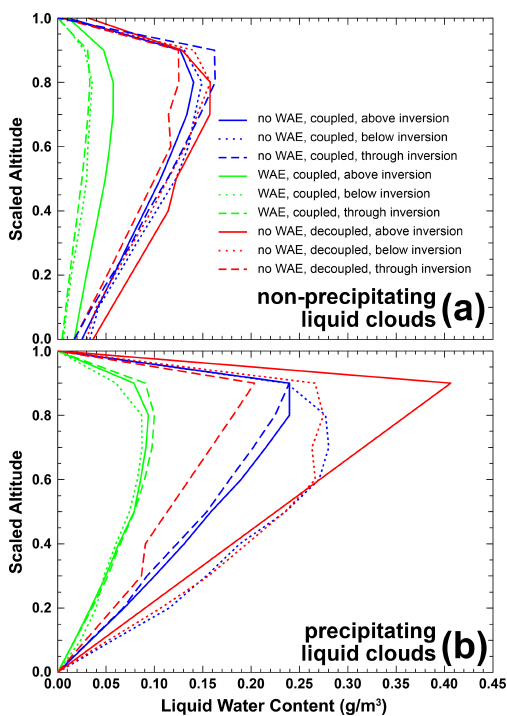
Figure 11. Scaled profiles of LWC for non-precipitating (a) and precipitating (b) liquid clouds observed for different PBL structure, temperature at 1km height, and location with respect to the main inversion. Zero and unity of the scaled altitude refer to cloud base and top, respectively. Categories with fewer than 100 profiles have not been